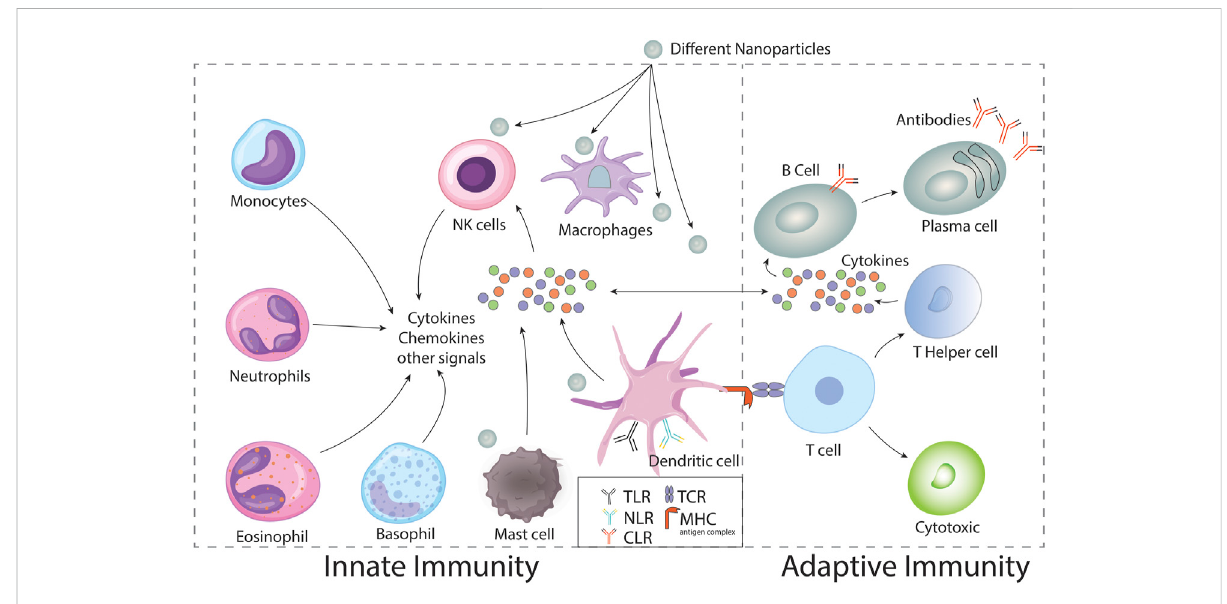
FIGURE 5 Nanoparticles from different sources Modulate innate and adaptive immune